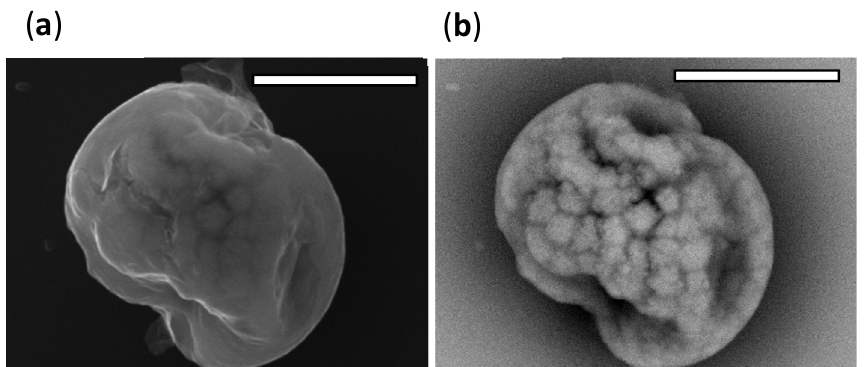
Figure 7. SEM micrographs of a representative particle (DMEM, 10% FBS, 0.5% w/v mucin) collected from the bottom of the falling droplet column, magnification ×10,000, scale bar 5 µm. ( a ) SED images show topographic information of the particle. ( b ) BED-C images show the presence of inclusions within the dried particle.